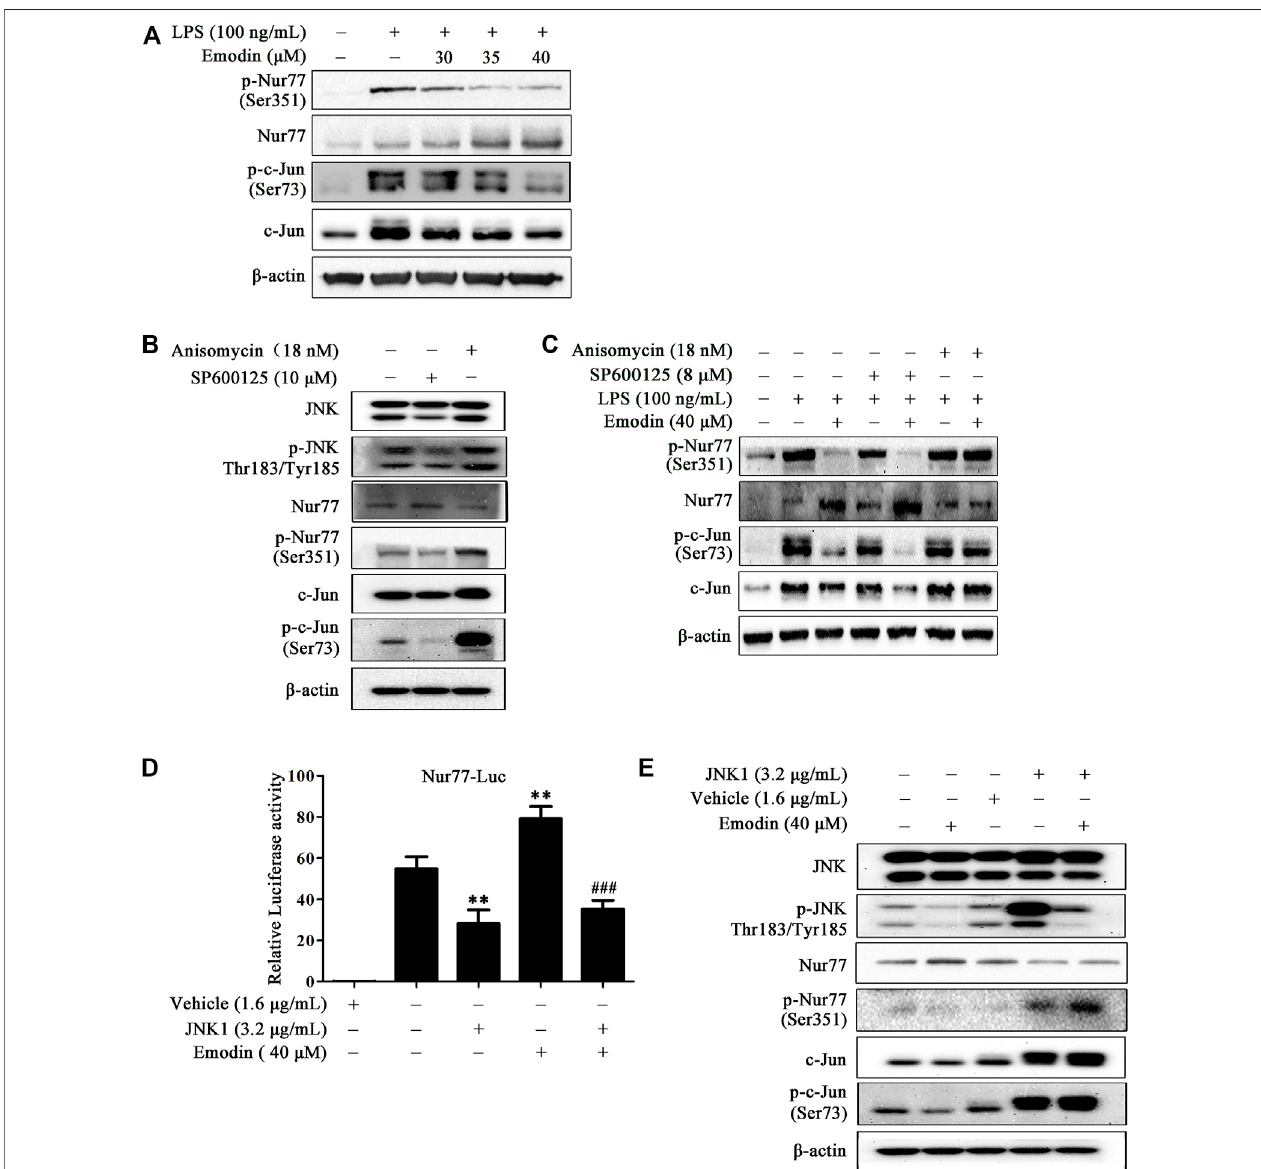
FIGURE 3 | Emodin regulates the Nur77/c-Jun pathway in LPS-stimulated RAW264.7 cells by inhibiting the JNK pathway. (A) Emodin regulates the Nur77/c-Jun pathway. RAW264.7 cells were pretreated with emodin (40 μ M) for 2 h followed by exposure to LPS (100 ng/ml) for 18 h. The expression levels of p-Nur77 (Ser351), Nur77, p-c-Jun (Ser73), and c-Jun were measured by Western blotting. (B) The functional veri fi cation of SP600125 and anisomycin. RAW264.7 cells were treated with SP600125(10 μ M) for 22 hor anisomycin (18 nM) for24 h. Theexpression levels ofp-JNK (Thr183/Tyr185), JNK, p-Nur77 (Ser351), Nur77, p-c-Jun (Ser73),and c-Junintotalcelllysatesweredetected byWestern blotting. (C) Anisomycin blockstheregulatoryeffects ofemodinontheNur77/c-Junpathway. RAW264.7 cellswere pretreated with SP600125 (8 μ M) for 2 h or anisomycin (18 nM) for 4 h, and then treated with emodin (40 μ M) for 2 h, followed by exposure to LPS (100 ng/ml) for another18 h.Theexpressionlevelsofp-Nur77(Ser351),Nur77,p-c-Jun(Ser73),andc-JunintotalcelllysatesweredetectedbyWesternblotting. (D) Emodinincreases the transcriptional activity of Nur77 via the JNK pathway. HEK293.7T cells were transfected with plasmid Nur77-luciferase (1.6 μ g/ml) and pRL-TK (1.6 μ g/ml) in the presence or absence of JNK1 plasmid (3.2 μ g/ml). After 24 h transfection, cells were treated with emodin for 8 h, and then luciferase assay was performed. Relative luciferase activity wasexpressed astheratioof fi re fl y toRenilla luciferase. Dataare presented asmean± SEM, n =3. ** p < 0.01 compared withthecontrolgroup; ### p < 0.001 compared with the emodin group. (E) Emodin increases the protein expression of Nur77 via the JNK pathway. HEK293.7T cells were transfected with JNK1 plasmid (3.2 μ g/ml). After 24 h transfection, cells were treated with emodin for 8 h, and then the expression levels of p -JNK (Thr183/Tyr185), JNK, p-Nur77 (Ser351), Nur77, p-c-Jun (Ser73), and c-Jun in total cell lysates were assessed using Western blotting.